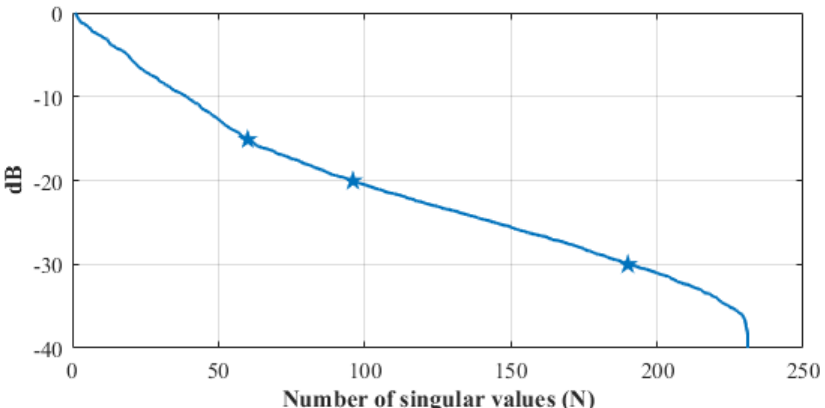
Figure 7. Singular values (dB) of the discretized scattering operator versus their indices; the stars indicate the three main slope